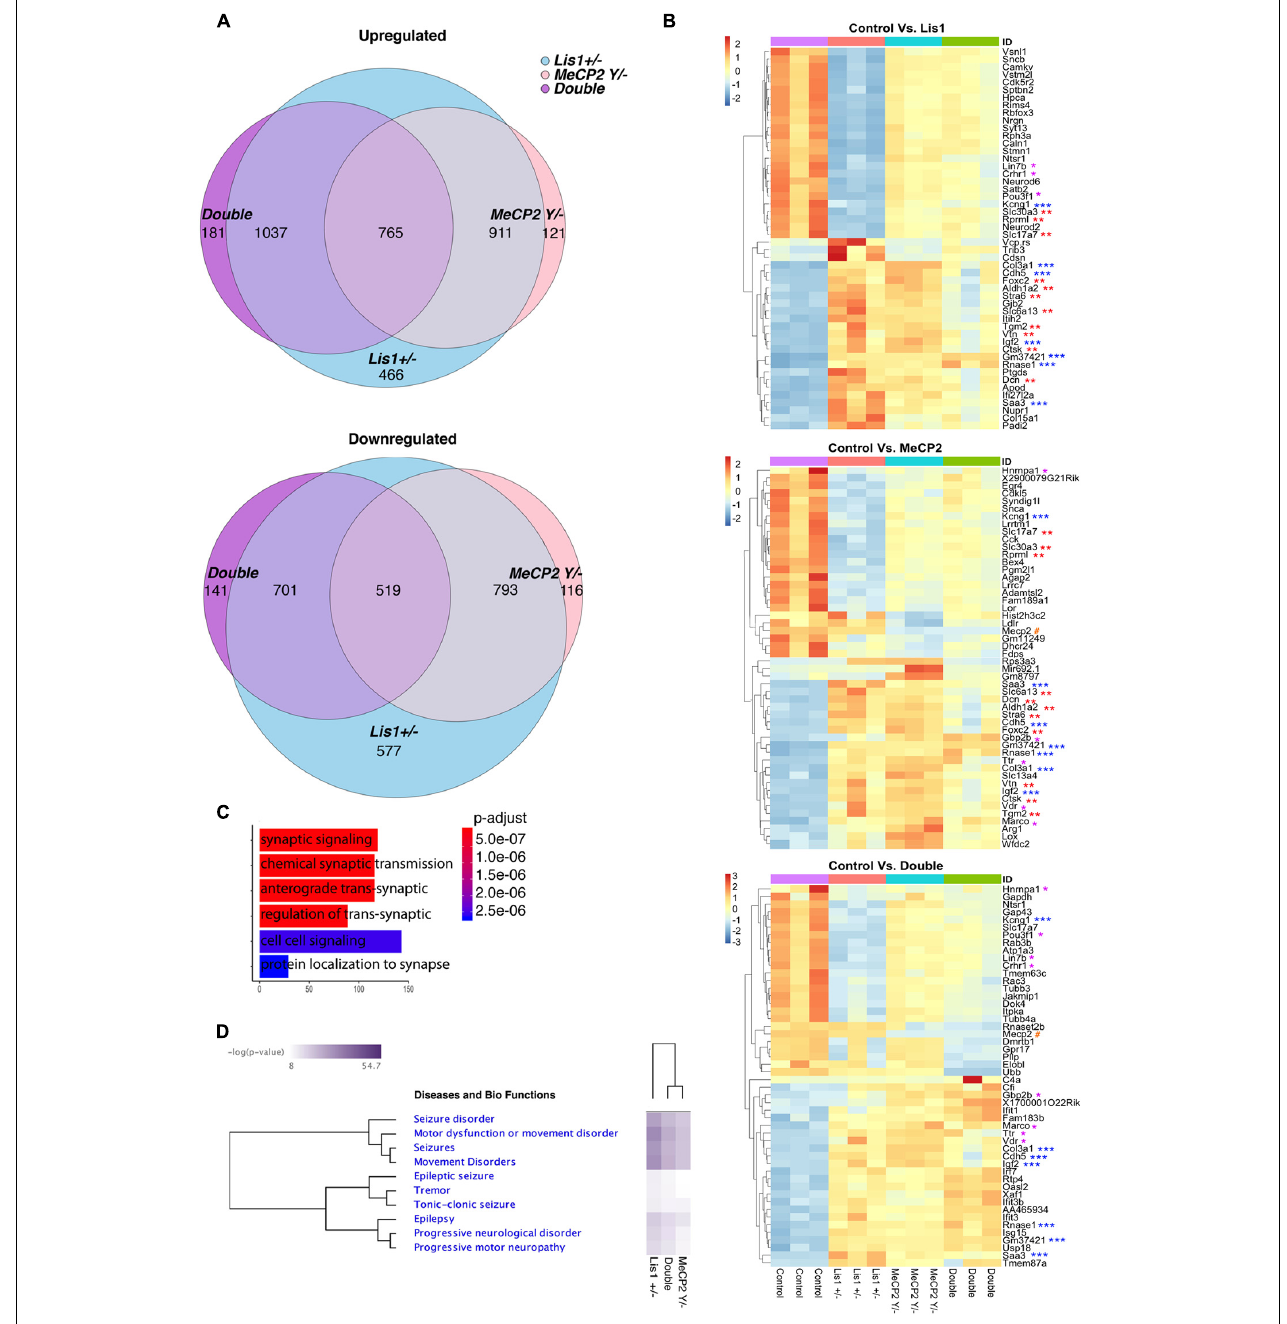
FIGURE 2 | An integrated RNA sequencing approach to identify LIS1-MeCP2 genetic interaction in mouse primary neurons. (A) The number in each circle of 3-set Venn diagrams represents the differentially expressed (DE) genes between the different comparisons (Control versus Lis1 ± , MeCP2 Y/– and Double). For Up and Down regulated genes with Deseq2 p -adjusted value < 0.05 and log2 foldchange more than 1 and less than –1 were determined, respectively. The overlapping numbers stand for the mutual differentially expressed genes between the different comparisons and non-overlapping numbers belong to the specific genes unique to each condition. (B) Hierarchical clustering and heatmap representation of top 50 differentially expressed genes in the primary neurons of the indicated groups (Control vs. Lis1 ± , Control vs. MeCP2 Y/– and Control vs. Double). The color-coded scale represents the z -score of DESeq2 log normalized expression values. The top differentially expressed common genes between Control vs. Double and Control vs. Lis1 ± or MeCP2 Y/– are marked with asterisk ( ∗ ), Control vs. Lis1 ± and Control vs. MeCP2 Y/– are marked with ( ∗∗ ) and common differentially expressed genes across all the comparisons are marked with ( ∗∗∗ ). MeCP2 is denoted with #. (C) Enriched GO terms for top common significantly upregulated genes in Control group, in comparison to all the mutants with the range of associated p -adjusted values. (D) Ingenuity pathway analysis of the selected enriched terms in the Diseases and bio-functions category with the hierarchical clustering and representative heatmap of p -values in all the mutant